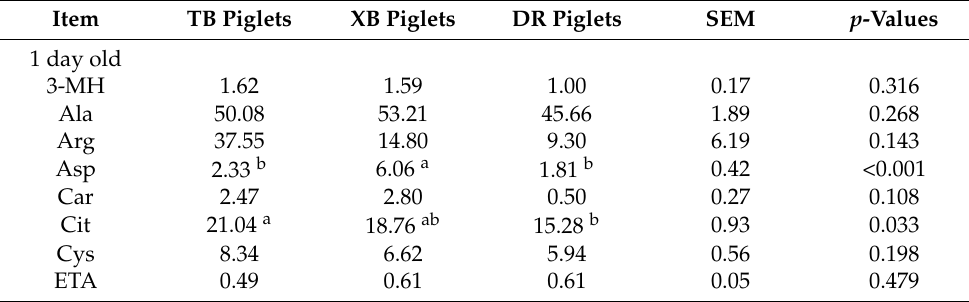
Table 3. Differences in plasma-free amino acids of piglets at different ages ( µ